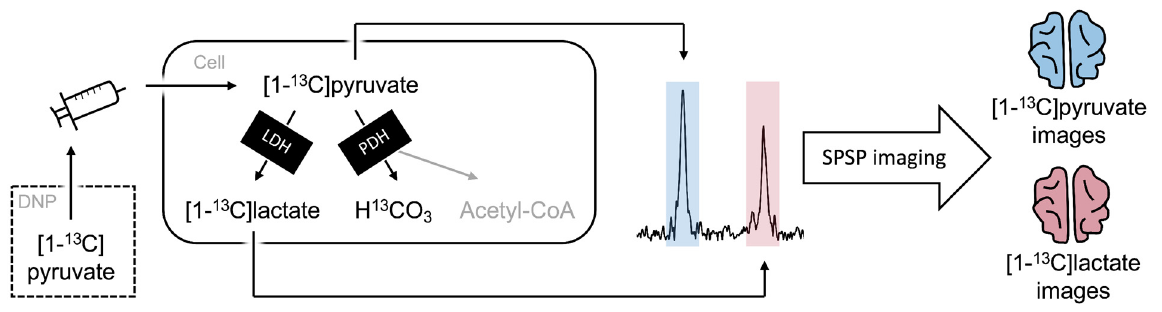
Figure 1. In hyperpolarized MRI, [1- 13 C]pyruvate is brought to a state of polarization >10.000 times above the thermal equilibrium using dynamic nuclear polarization (DNP). Following hyperpolarization, the product is administered intravenously. In the target organ, the [1- 13 C]pyruvate is taken up and metabolized to lactate or bicarbonate through the lactate dehydrogenase (LDH) or the pyruvate dehy- drogenase (PDH), respectively. This yields three separate peaks that are shifted enough to be imaged separately using spectral-spatial (SPSP) imaging. The spectrum shown is from the patient of this case report. It was obtained after imaging where the signal-to-noise was too low to observe